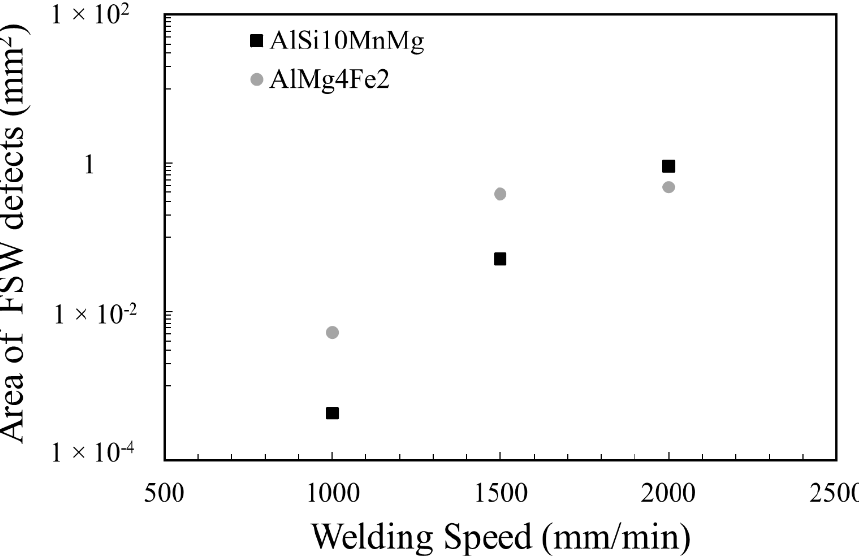
Figure 9. Area of FSW defects in AlSi10MnMg and AlMg4Fe2 welds as a function of welding speed. No value is displayed at 500 mm/min since these welds are considered free of FSW defects.